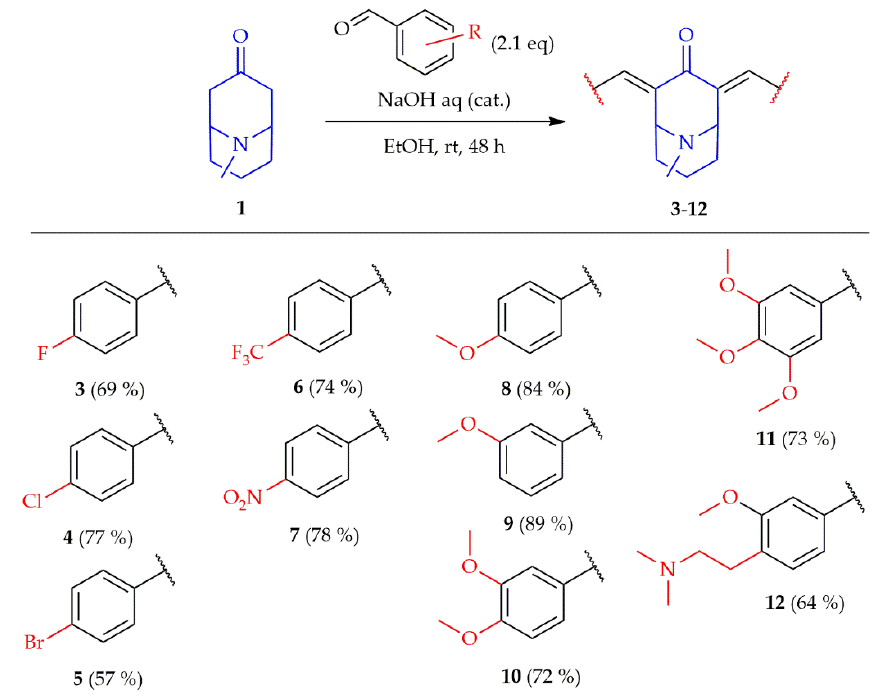
Scheme 7. Synthesis of 2,6-bis(benzylidene)pseudopelletierine derivatives.